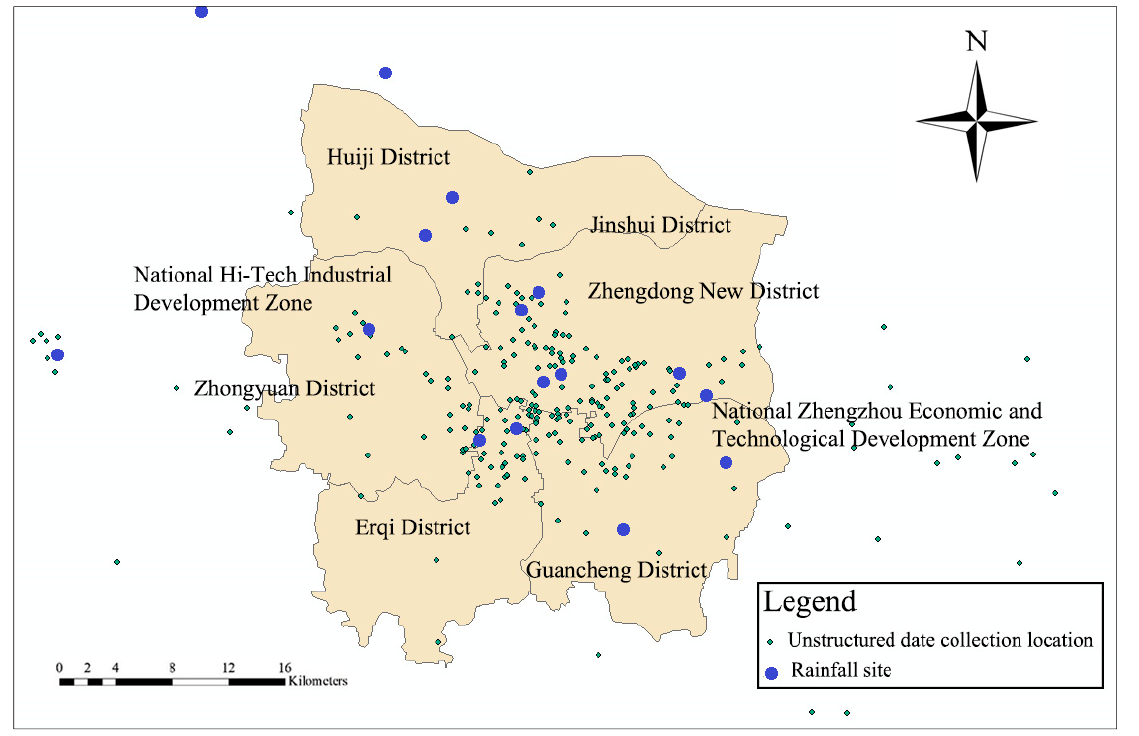
Figure 3. Geographic distribution of the rainfall unstructured data collection points, from 2011 to 2018, and the rainfall stations in Zhengzhou City.